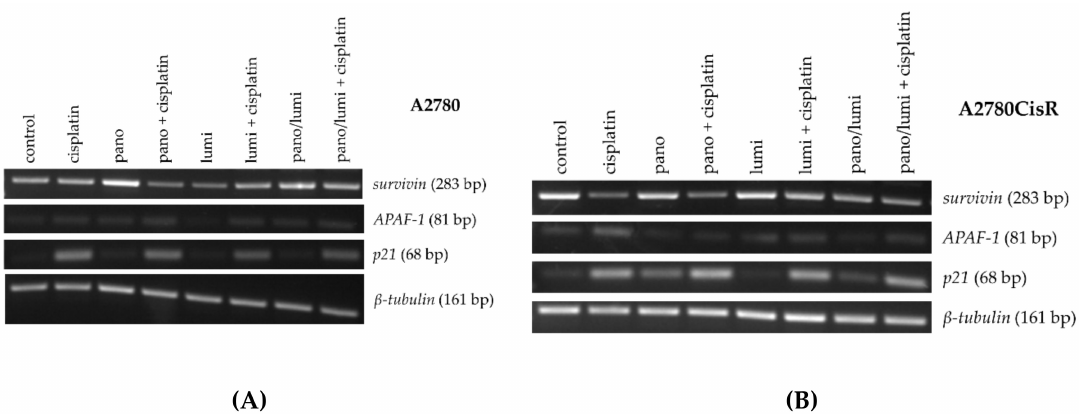
Figure 5. E ff ects of HDACi or HSP90i preincubation prior to cisplatin on apoptosis-related genes. Gene expression data were obtained by PCR. ( A , B ) A2780 and A2780CisR cells were treated with the indicated inhibitors or their combinations. For combination treatments panobinostat and / or luminespib were administrated 48 h prior to 24 h cisplatin treatment in an IC 50 . Cell line specific untreated controls were obtained by 72 h incubation with cell culture medium. The concentrations used ( A , B ) were the same as for cytotoxicity combination studies (Figure S6 and Table 2). One representative agarose gel is shown. Densitometric evaluation can be found in Figure